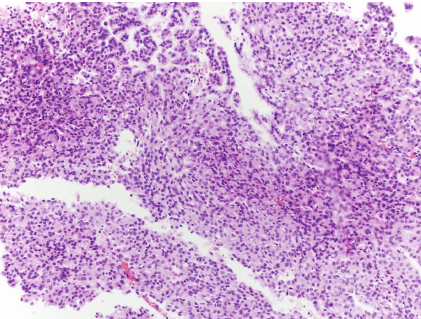
Figure 4: Tumor cells showing spindle cell morphology at the cen- ter.